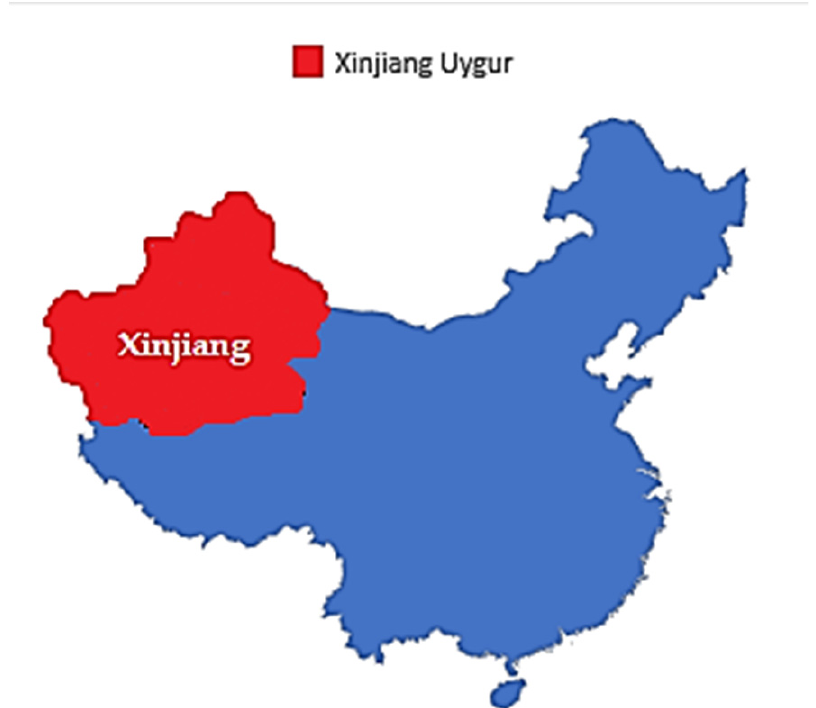
Figure 1. A map illustrating the geographic location of the Xinjiang-Uigur Autonomous Region in China.